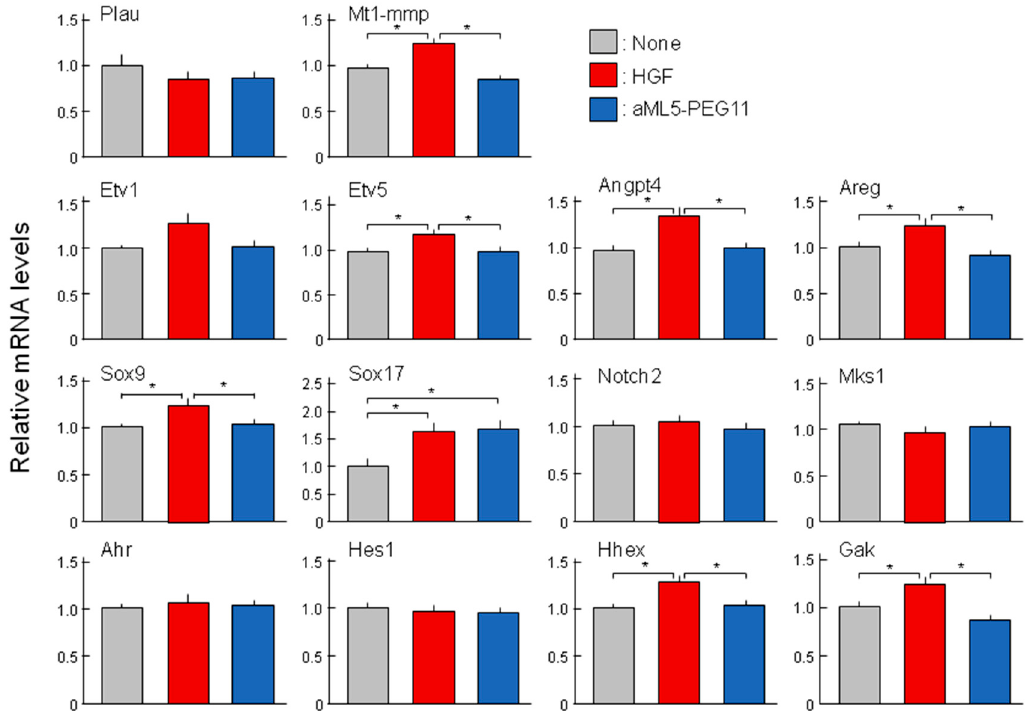
Figure 7. Changes in the expression of genes involved in epithelial tubulogenesis and bile duct development. HuCCT1 cells cultured in a collagen gel matrix were treated with 100 nM aML5-PEG11 or 3.3 nM HGF for 8 hours. Gene expression was analyzed by quantitative RT-PCR. The expression levels in the culture without aML5-PEG11 or HGF were regarded to be 1.0. Each value represents the mean ± SE of measurements ( n = 7). The asterisk indicates a significant difference ( p < 0.05).